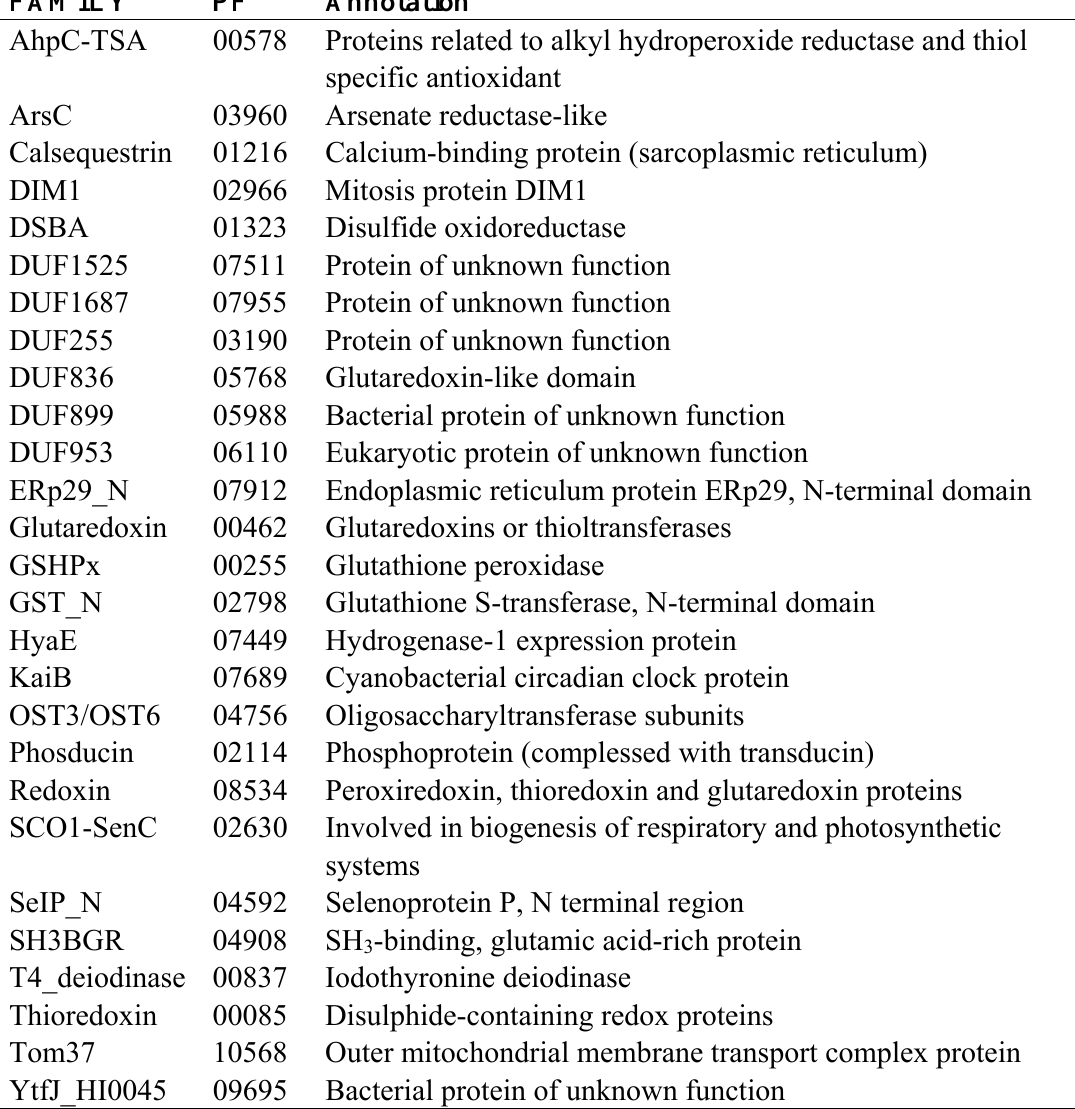
Table 1. The clan Thioredoxin-like (CL0172) currently includes 27 member families related to the thioredoxin family (Pfam protein families database)